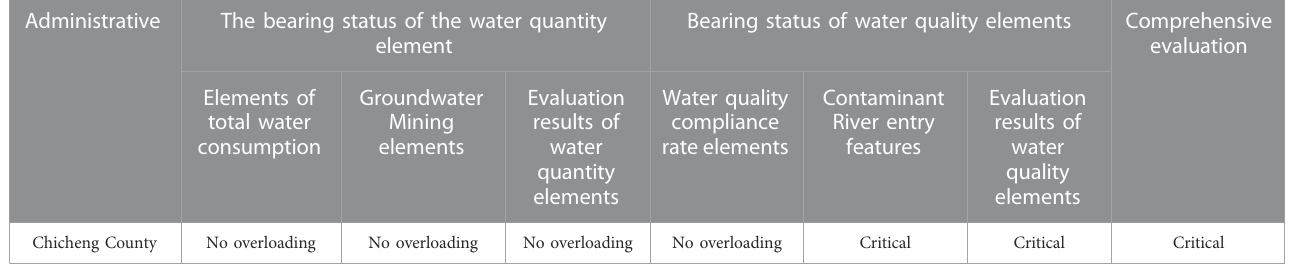
TABLE 7 Current status year (2018) water carrying capacity evaluation table. Administrative The bearing status of the water quantity